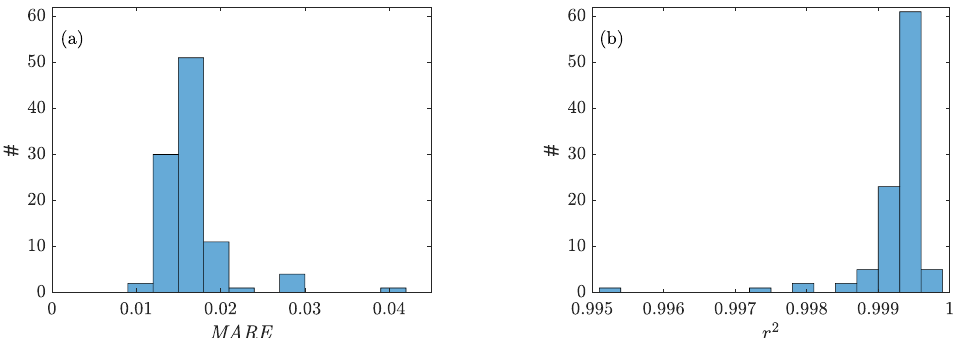
Figure A5. The distributions of ( a ) MARE and ( b ) r 2 for 100 trained ANNs using the Bayesian regularization backpropagation with a simple architecture: two hidden layers, each with five